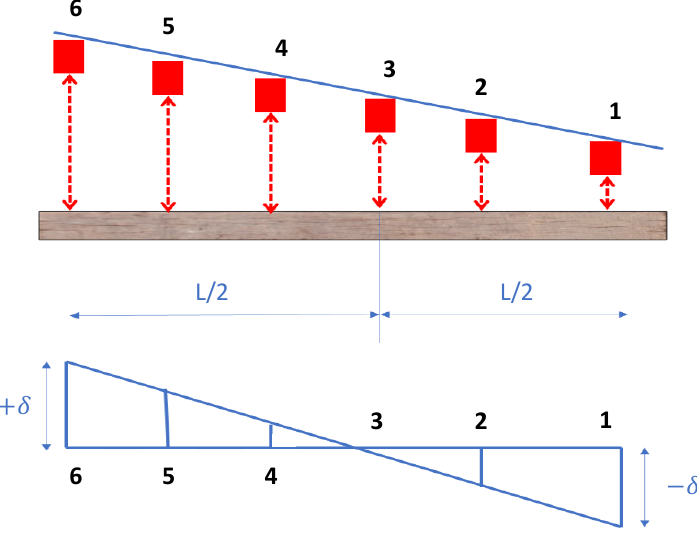
Figure 10. Bias removal from tie deflection